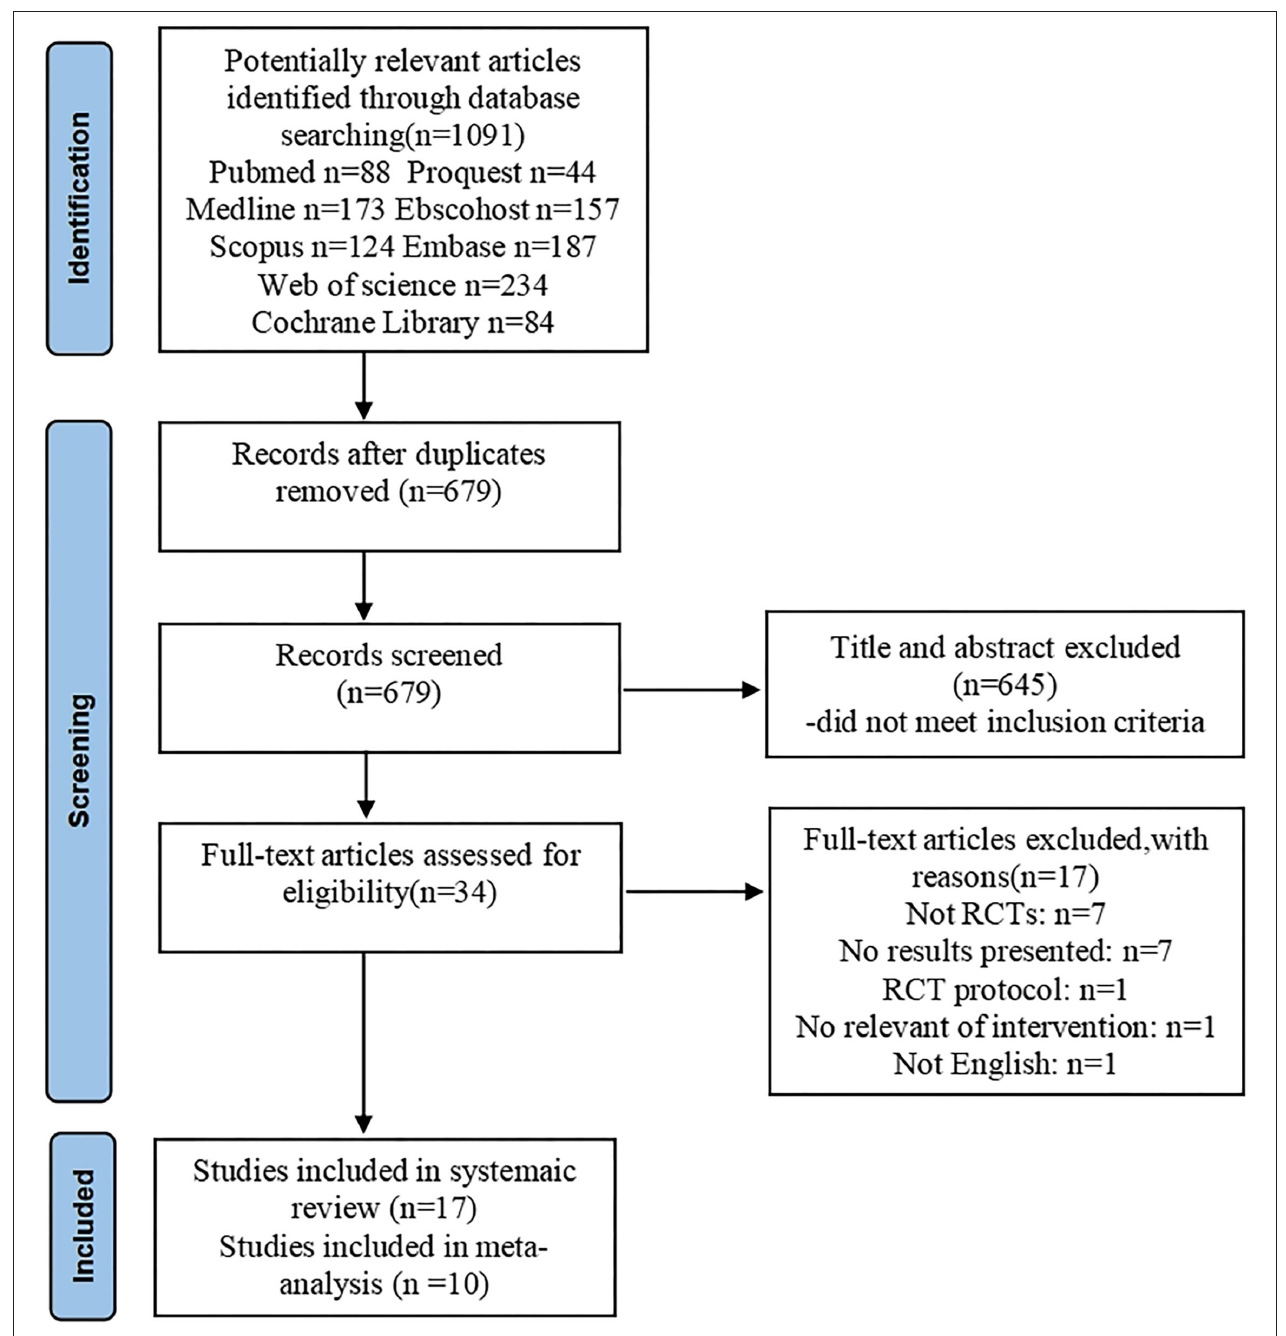
FIGURE 1 | Flowchart of the